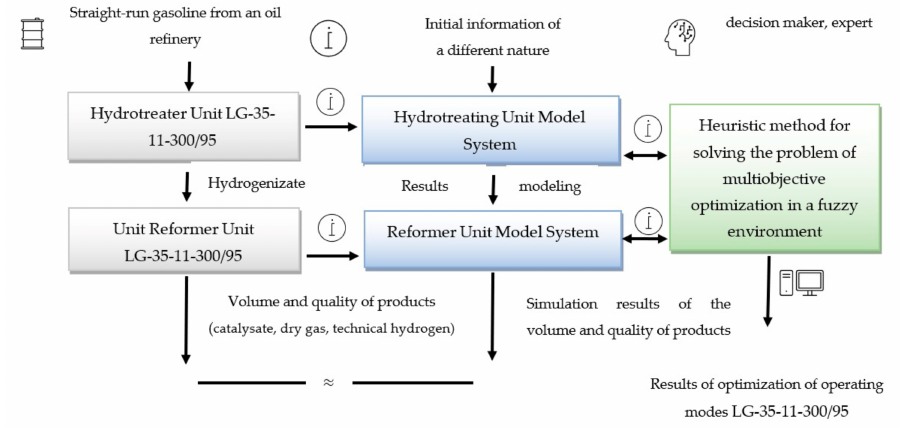
Figure 1. A general scheme showing the structure of the present